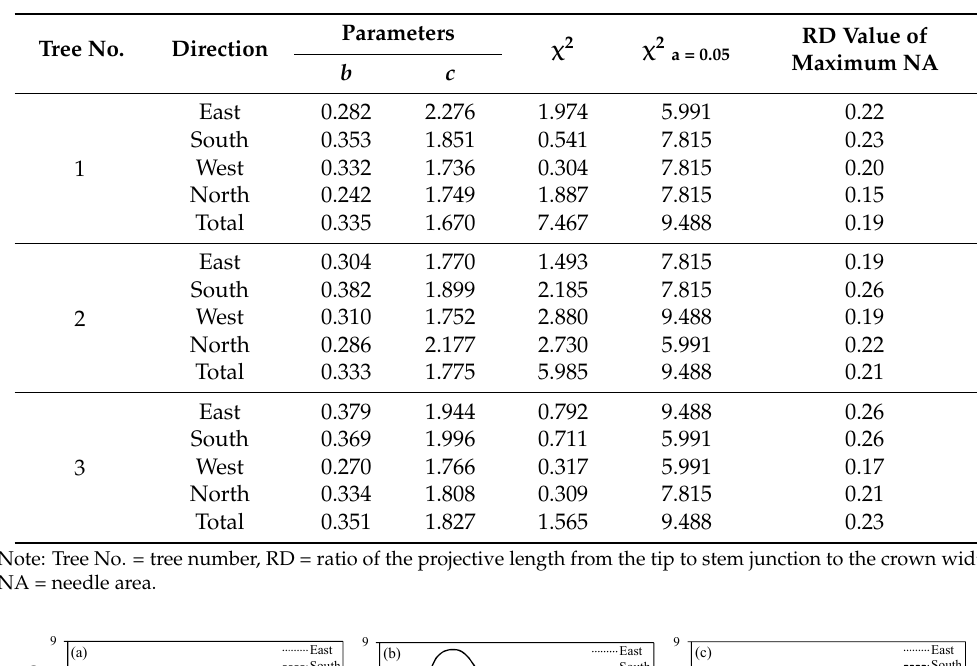
Table 3. Parameter estimates and Chi-square test of the Weibull function fitted to the horizontal distribution of NA in different directions. Tree No.